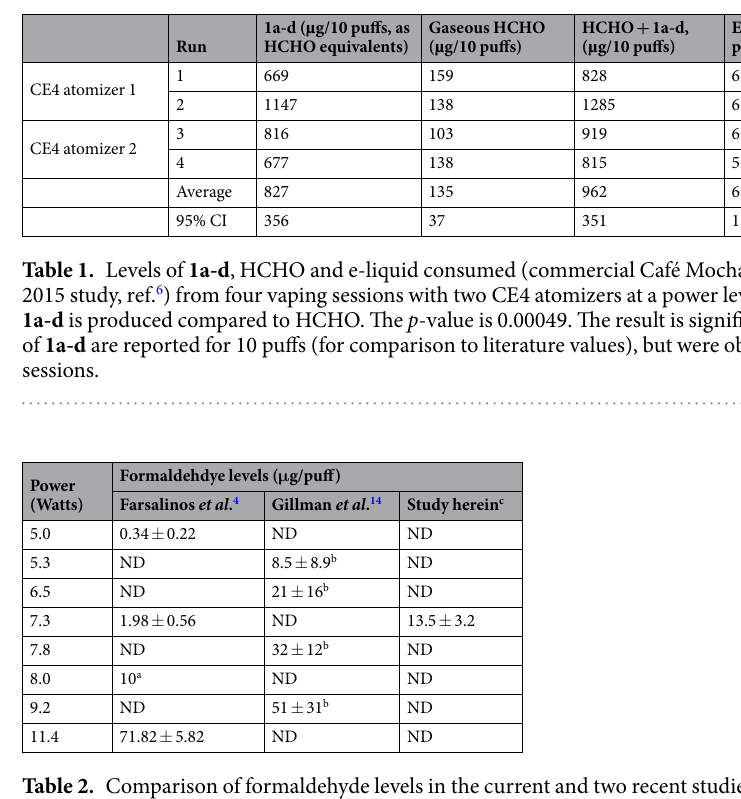
Table 2. Comparison of formaldehyde levels in the current and two recent studies using a CE4 e-cigarette. The two cited studies 4,14 did not involve separating and quantifying 1a-d and gaseous HCHO separately, and may therefore represent a mixture in which 1a-d partially converted to HCHO prior to DNPH-trapping. The results shown from the study herein correspond to only gaseous HCHO levels for comparison. ND = not described. a Reported in ref. 4 as 100 μ g/10 puffs. b E-liquid was composed of 48% PG in GLY and 2% nicotine, and formaldehyde values were obtained using a CE4 atomizer with an Innokin iTaste VV4 battery. c HCHO levels correspond to those in Table